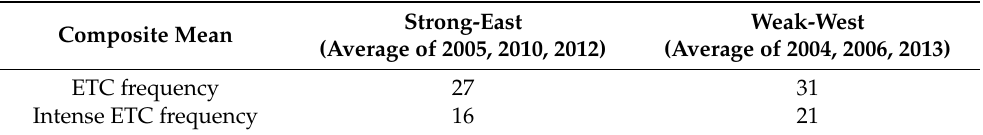
Table 2. Composite means of the ETC frequency and intense ETC frequency in dust source region (combined R1 and R2) for the Strong-East and Weak-West periods over 95 ◦ –125 ◦ E, 35 ◦ –50 ◦ N in March. Strong-East Weak-West Composite Mean (Average of 2005, 2010, 2012) (Average of 2004, 2006, 2013) ETC frequency Intense ETC frequency Table 3. Same as Table 2, but for the ETC domain (125 ◦ –140 ◦ E, 35 ◦ –50 ◦ N). Strong-East Weak-West Composite Mean (Average of 2005, 2010, 2012) (Average of 2004, 2006, 2013) ETC frequency Intense ETC frequency 16